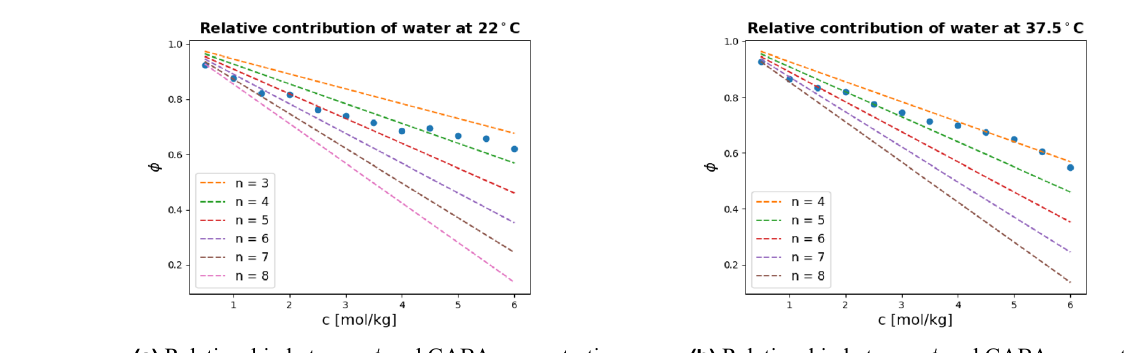
(a) Relationship between φ and GABA concentration c (b) Relationship between φ and GABA concentration c in deionized water at 37.5 °C. in deionized water at 22 °C. Figure 5. Relative contribution of the water molecules as a function of the GABA concentration c , in deionized water at 22 ◦ C and 37.5 ◦ C . Each straight line represents a prediction of the number of water molecules n bound to each GABA